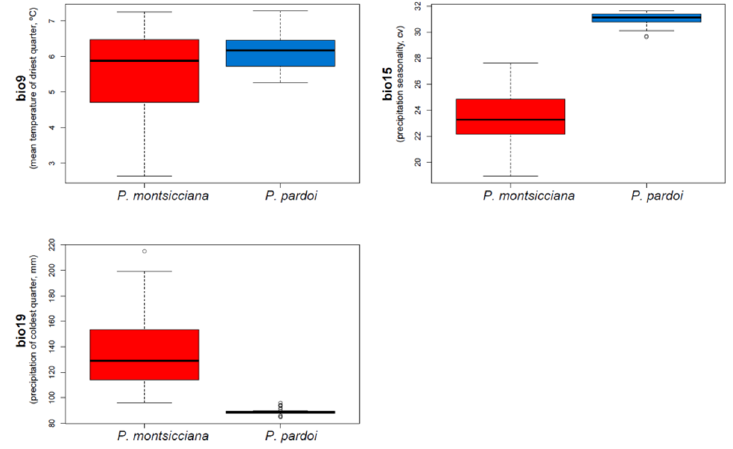
Figure 7. Boxplots of the seven selected variables related with temperature (bio3, bio6, bio7, bio8, bio9) and precipitation (bio15, bio19) where the Petrocoptis montsicciana and P. pardoi currently occur.